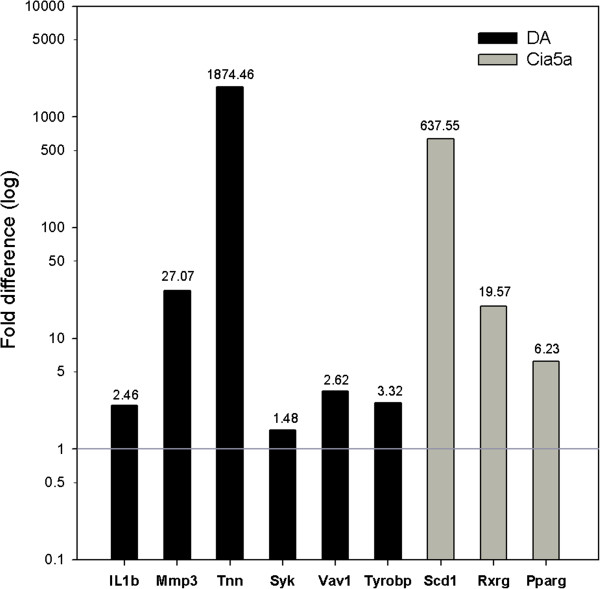
qPCR validation of the microarray results. Genes expressed in increased levels in DA (six genes, black bars) and genes expressed in increased levels in DA.F344(Cia5a) congenics (three genes, grey bars) were selected for qPCR confirmation. Fold-differences were log-transformed. The same RNAs used in the microarray experiments were used for qPCR. ΔCt was used for statistical analyses; all genes had p≤0.04, t-test.